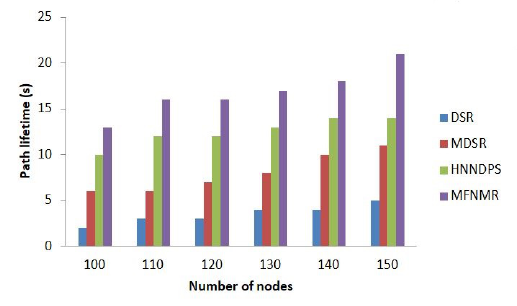
Figure 6. Path Lifetime Analysis based on Number of Nodes.